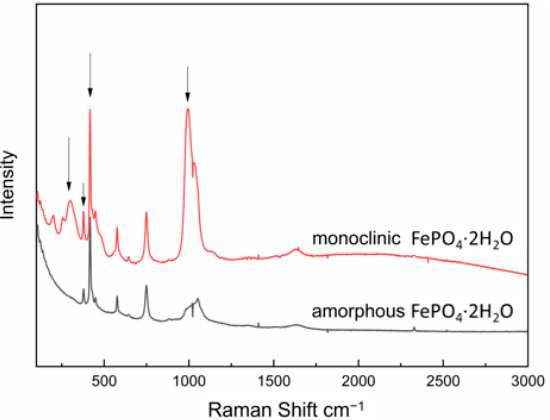
Figure 11. Raman spectra of slurries of monoclinic and amorphous FePO 4 ·2H 2 O during the transformation.